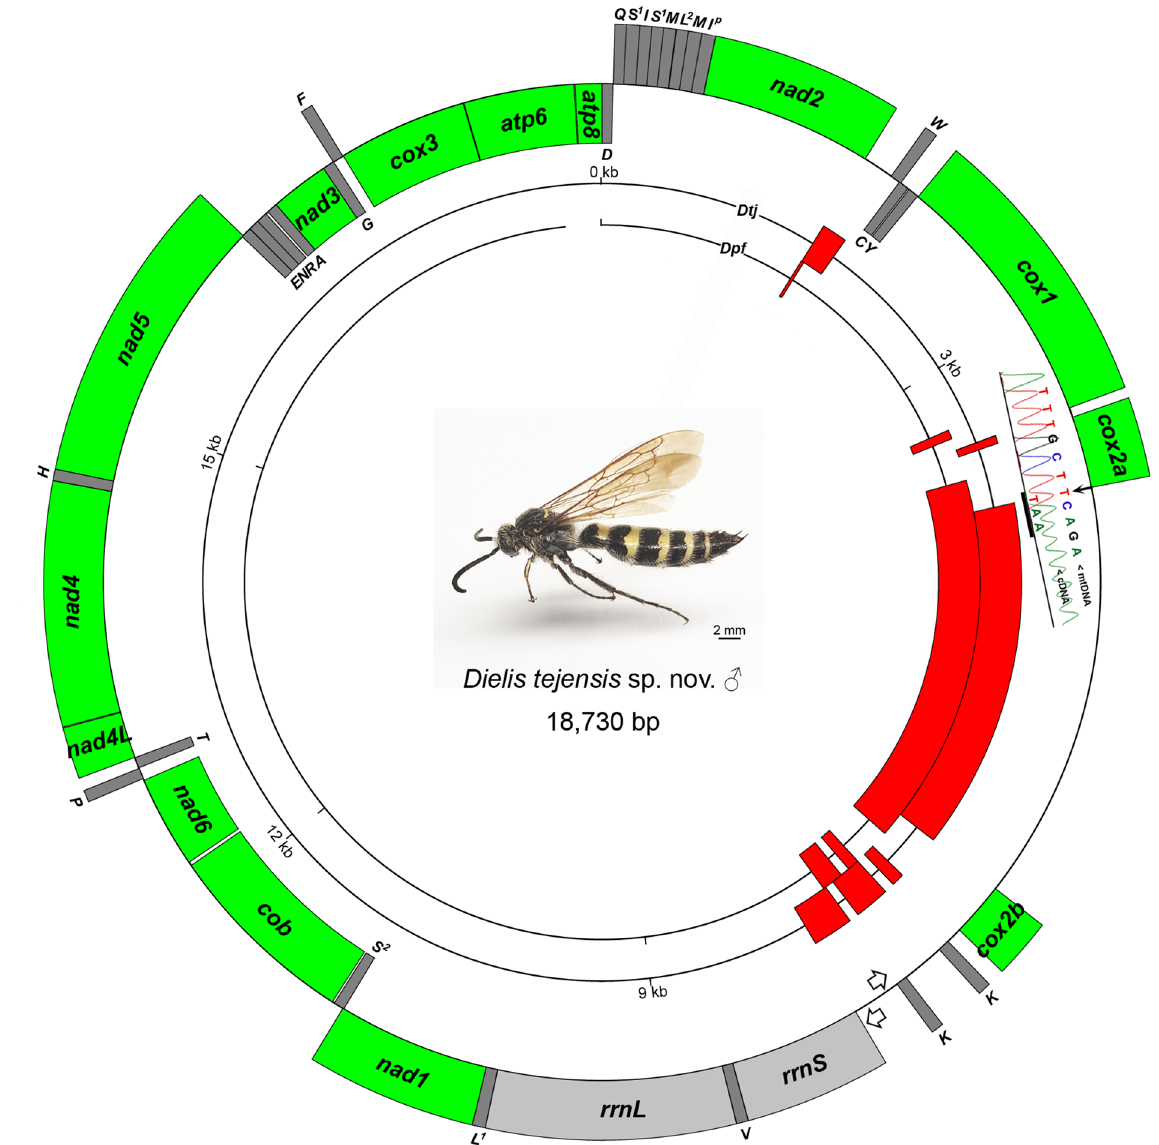
Figure 1. D. tejensis sp. nov. and its mitochondrial genome. Open arrows indicate the location of putative promoters and directions of polycistronic transcription; capital letters represent trn gene symbols ( I p , putative trnI pseudogene). The electropherogram shows the cDNA sequence around the cox2a 3 ′ -end with termination codon T(AA) completed by polyadenylation. Concentric circles represent the mitogenomes of D. tejensis sp. nov. ( Dtj ) and D. p. fossulana ( Dpf ) (the last one is arbitrarily interrupted), with red marked location of intergenic regions larger than 25 bp, including the cox2 -splitting